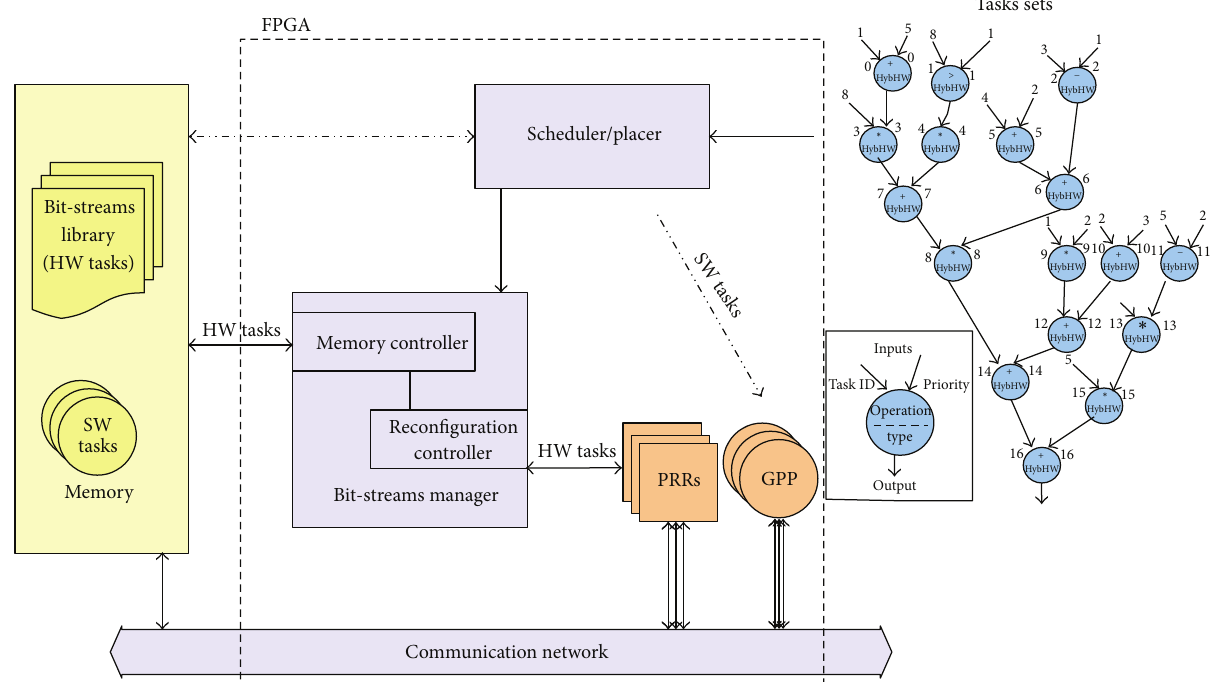
Figure 2: Reconfigurable OS: essential